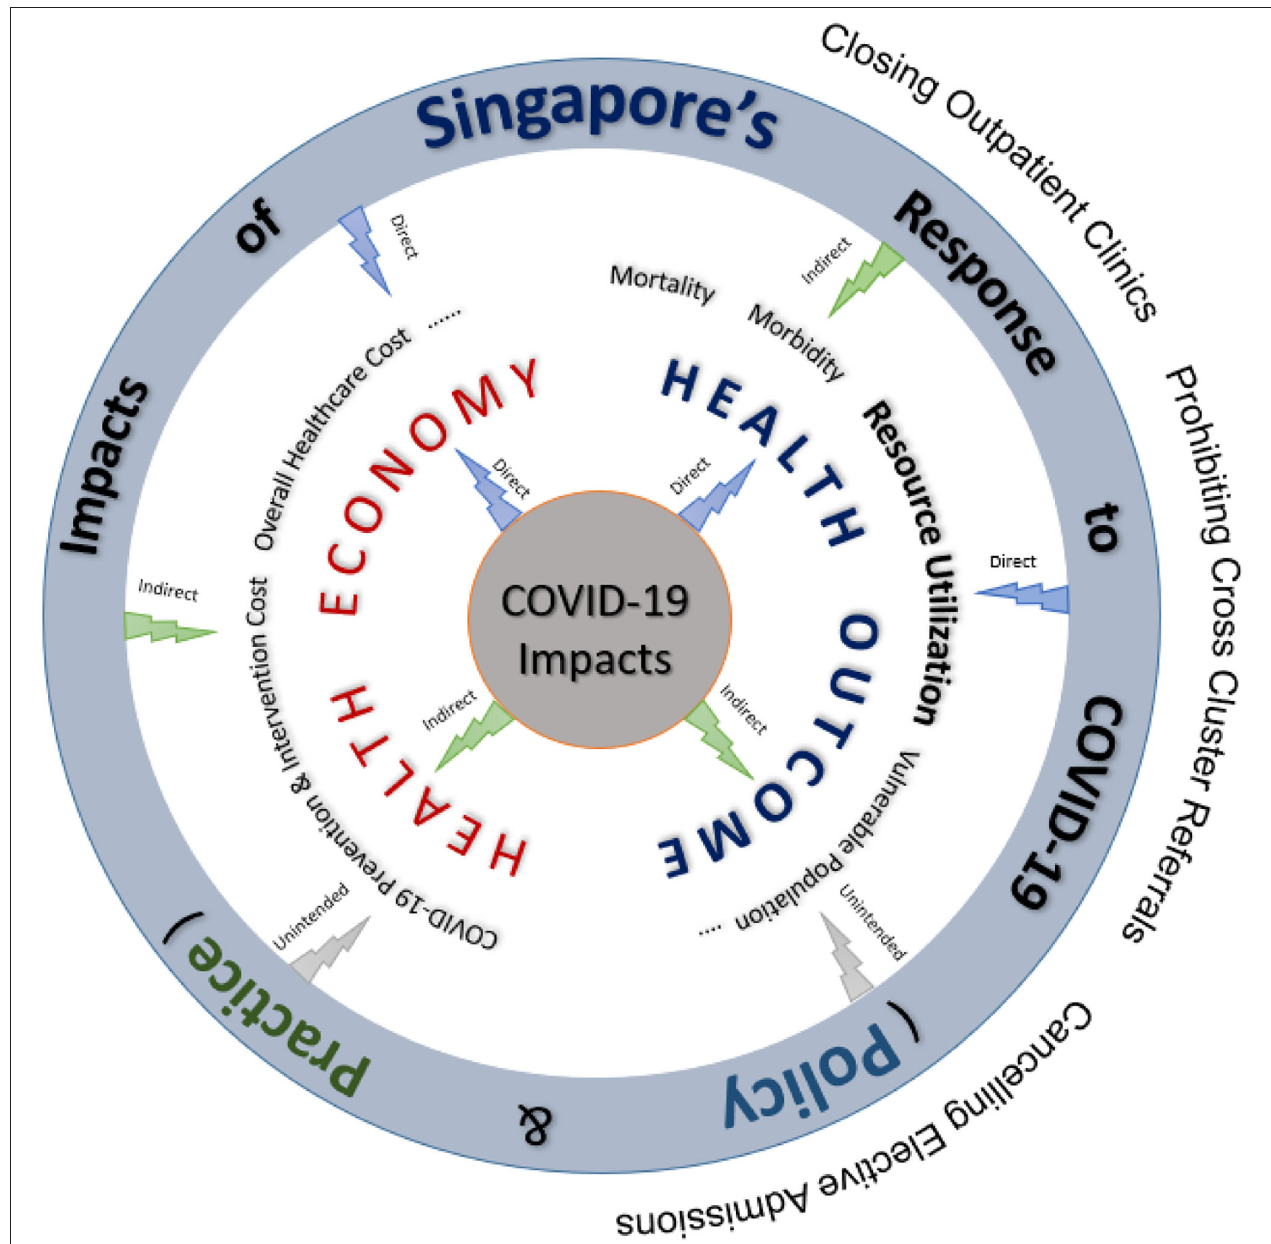
FIGURE 1 | High-level Schematic of the Systems Modeling Framework in Singapore.